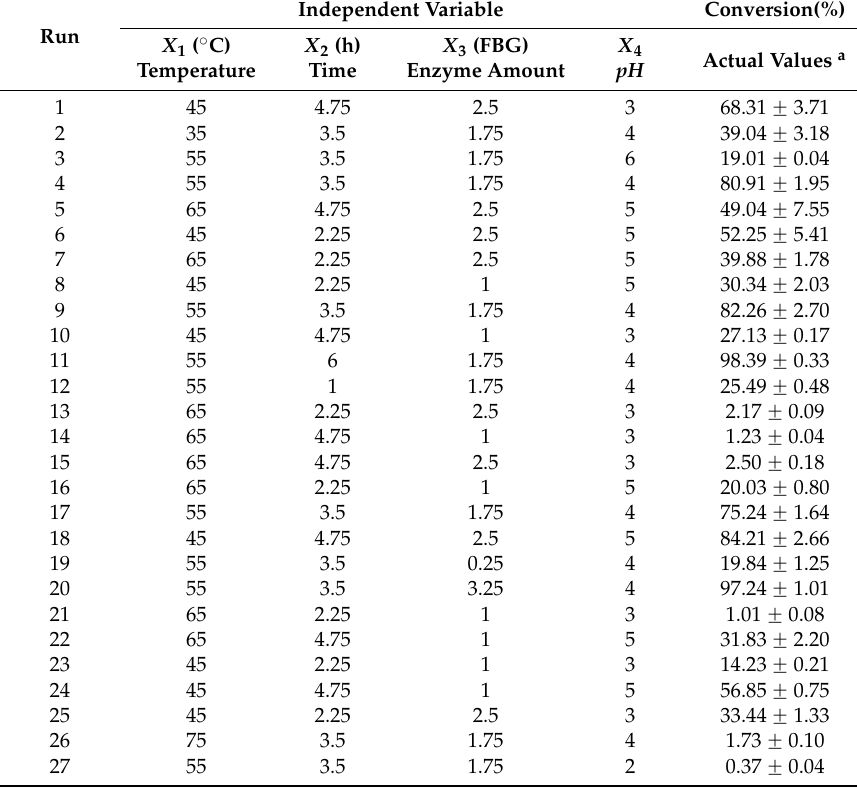
Table 1. Central composite design and observed experimental data for 5-level-4-factor response surface